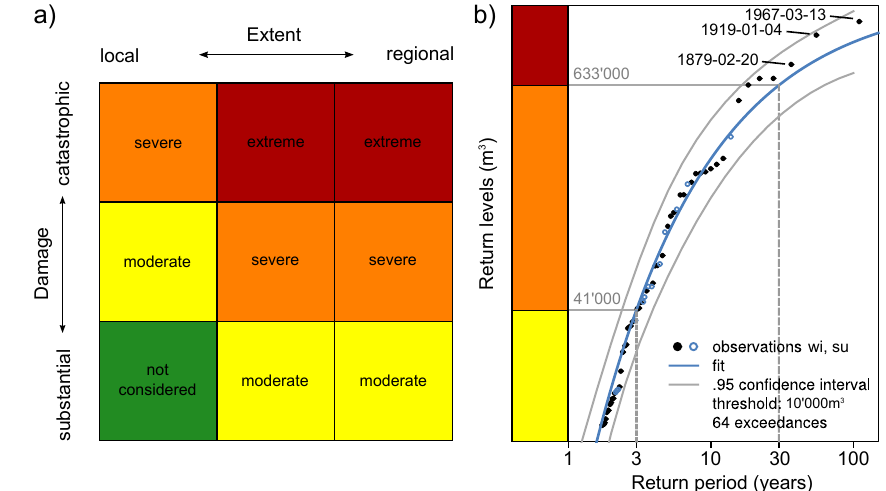
Figure 1. (a) Conceptual guideline for the three-step classification of windstorm severity, based on two-dimension intensity and spatial extent. Minor storms are not considered (green box) for the windstorm catalog. Classes are called moderate (yellow boxes), severe (orange) and extreme (red). See also Table 2. (b) Return level plot of the normalized, declustered windfall timber volumes (m 3 ; black dots for winter, blue circles for summer storms) from the storm collection database (STC) between 1959 and 1967. Return periods (years, x axis) of 1, 3 and 30 years set the threshold return levels (m 3 , y axis) for moderate (here, all 64 exceedances ≥ 10000m 3 ), severe (41000m 3 ) and extreme (633000m 3 ) events. The color bar visualizes the analogy with (a) . Dates of the three most extreme windstorm events are